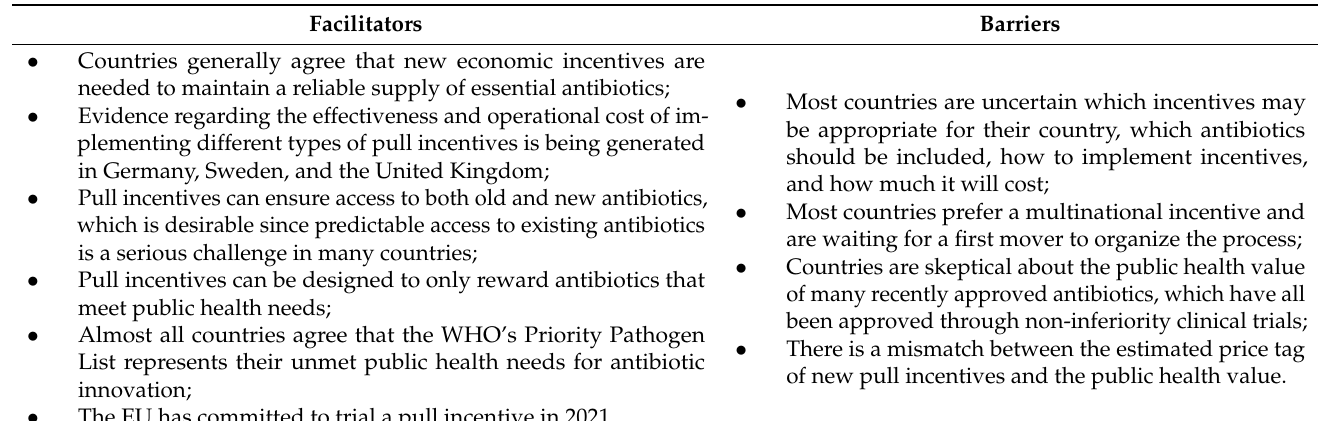
Table 1. Facilitators and barriers to implementing incentives for antibiotic access and